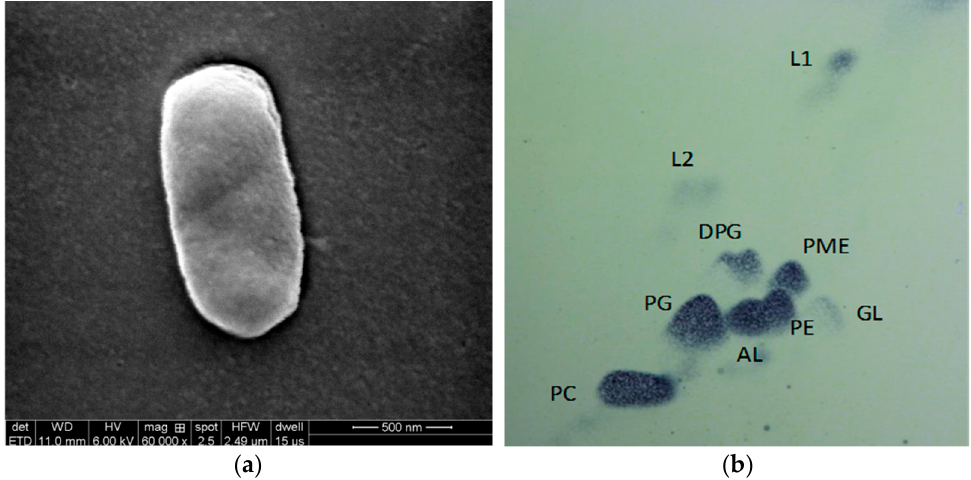
Figure 2. ( a ) Scanning electron microscopy (SEM) of strain TDYN1; ( b ) polar lipid profile of strain TDYN1.